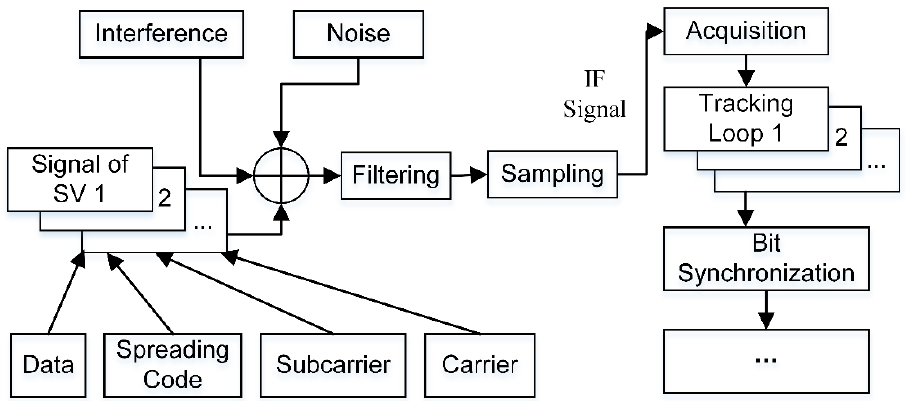
Figure 11. Simulation Figure 11. simulation scheme. Figure 11. simulation scheme.